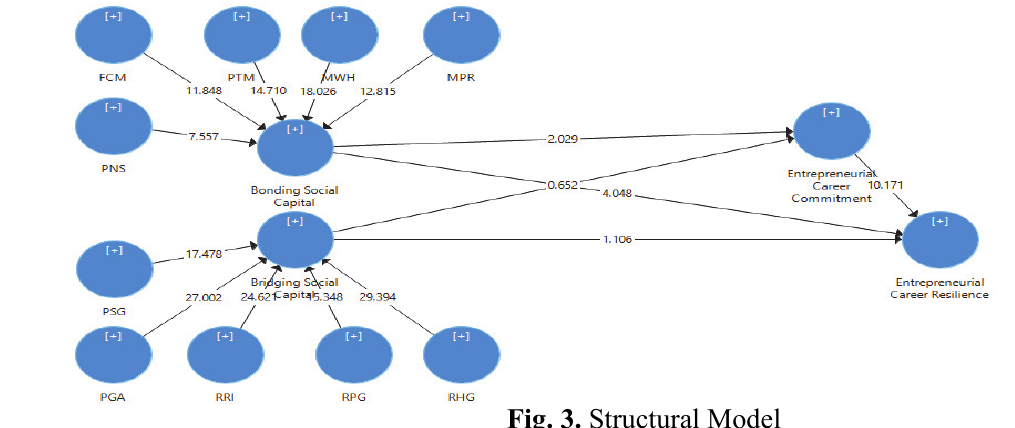
Structural Model Assessment (Direct Effect) Relationships